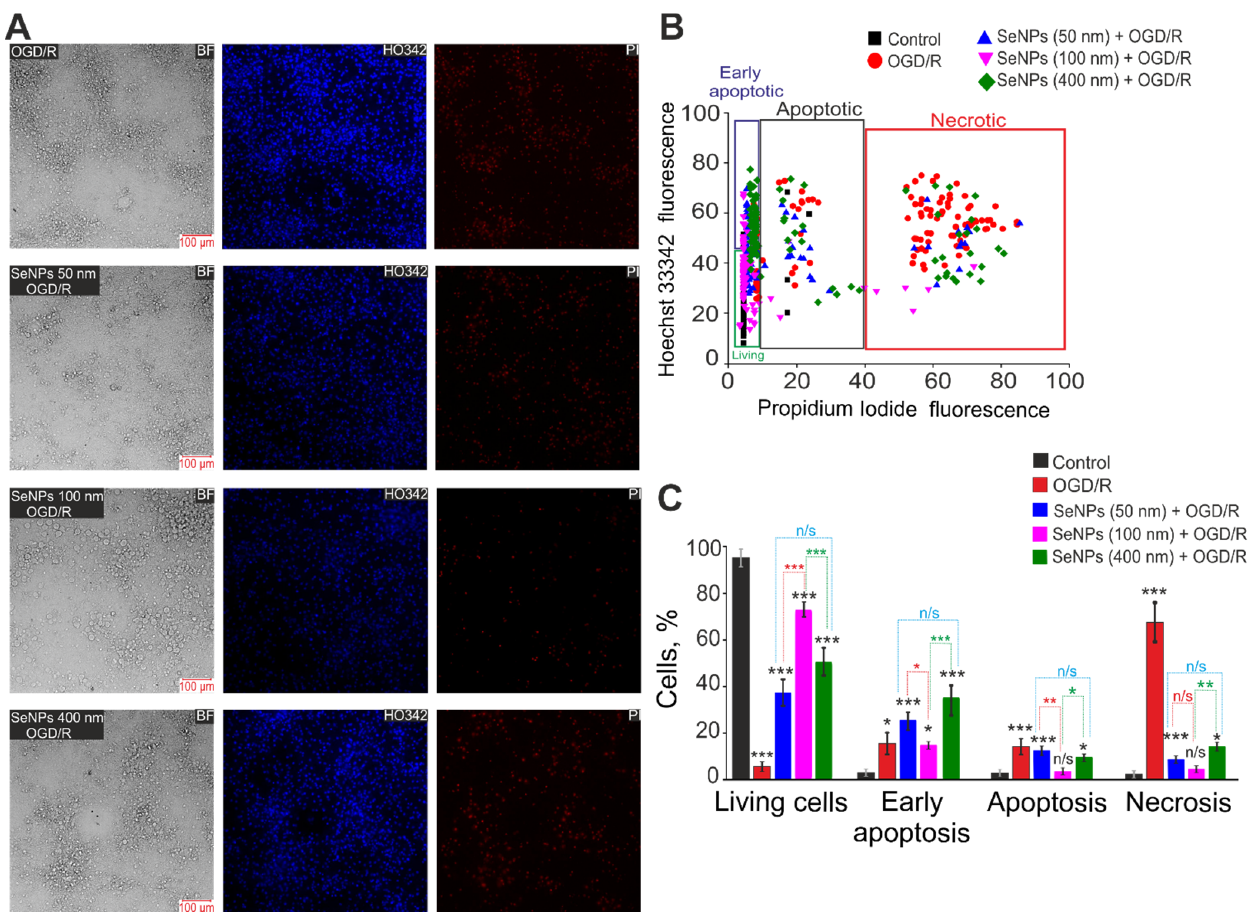
Figure 5. The effectiveness of the cytoprotective action of SeNPs depending on the size on the survival of cerebral cortex cells after 2-h OGD and 24-h reoxygenation (OGD/R). ( A )—Double staining of cells with Hoechst 33342 (HO342) and Propidium iodide (PI) after 2-h OGD and 24-h reoxygenation. SeNPs’ applications at a concentration of 3 µ g/mL were performed 24 h before the OGD/R induction experiments. BF—bright-field microscopy. ( B )—Cytogram demonstrating the viability of cortical primary cultured neurons and astrocytes. X -axis—the intensity of PI fluorescence; Y -axis—the intensity of Hoechst 33342 fluorescence. Cells were stained with the probes 24 h after the OGD/R. ( C )—Effect of 3 µ g/mL of different-sized SeNPs on the induction of necrosis and apoptosis 24 h after OGD/R. N cell cultures = 5; n coverslips with cells for each sample = 5. For panels D, results are presented as mean ± SEM; n/s—data not significant ( p > 0.05), * p < 0.05, ** p < 0.01, and *** p < 0.001 compared experimental groups with control (without SeNPs and OGD/R). Comparisons between experimental groups of different sized SeNPs are marked by red (50 nm-sized SeNPs vs. 100 nm-sized), green (100 nm-sized SeNPs vs. 400 nm-sized) or blue (50 nm-sized SeNPs vs. 400 nm-sized)